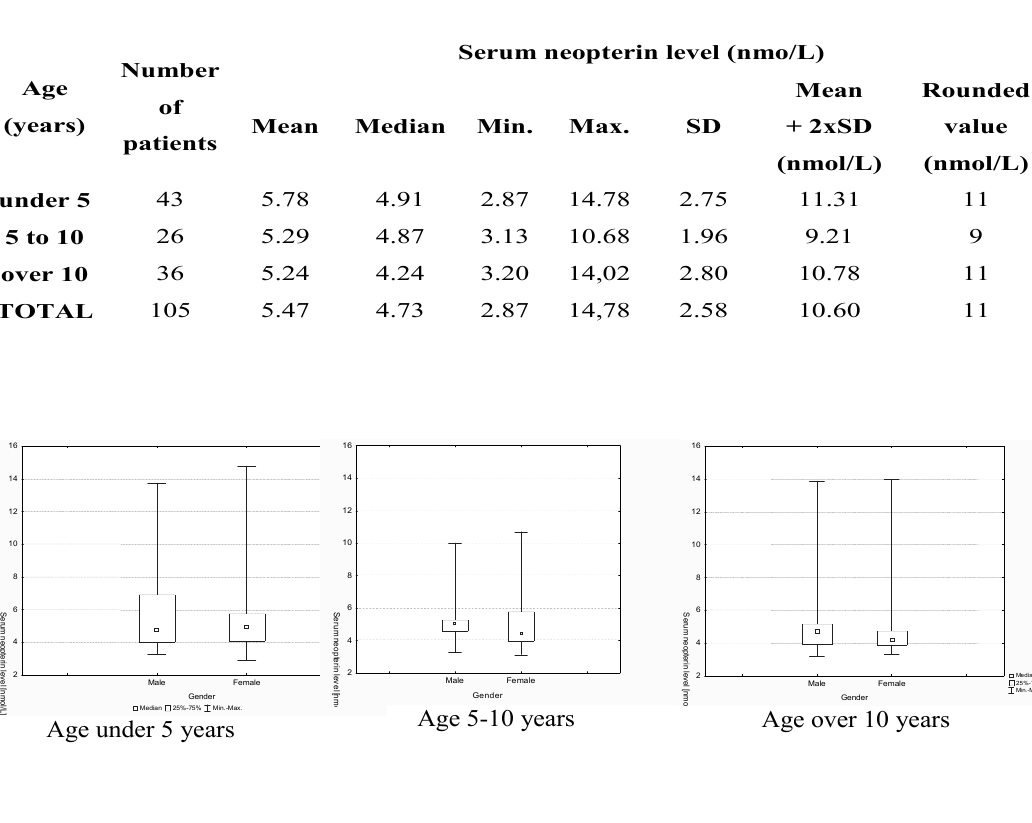
Table 1. Serum neopterin level in different age groups